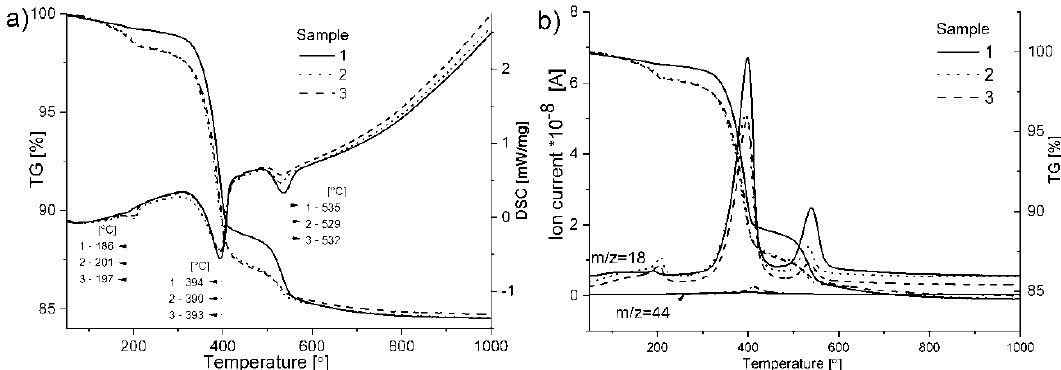
Figure 3. Thermal analysis of studied samples, ( a ) TG-DSC, ( b )